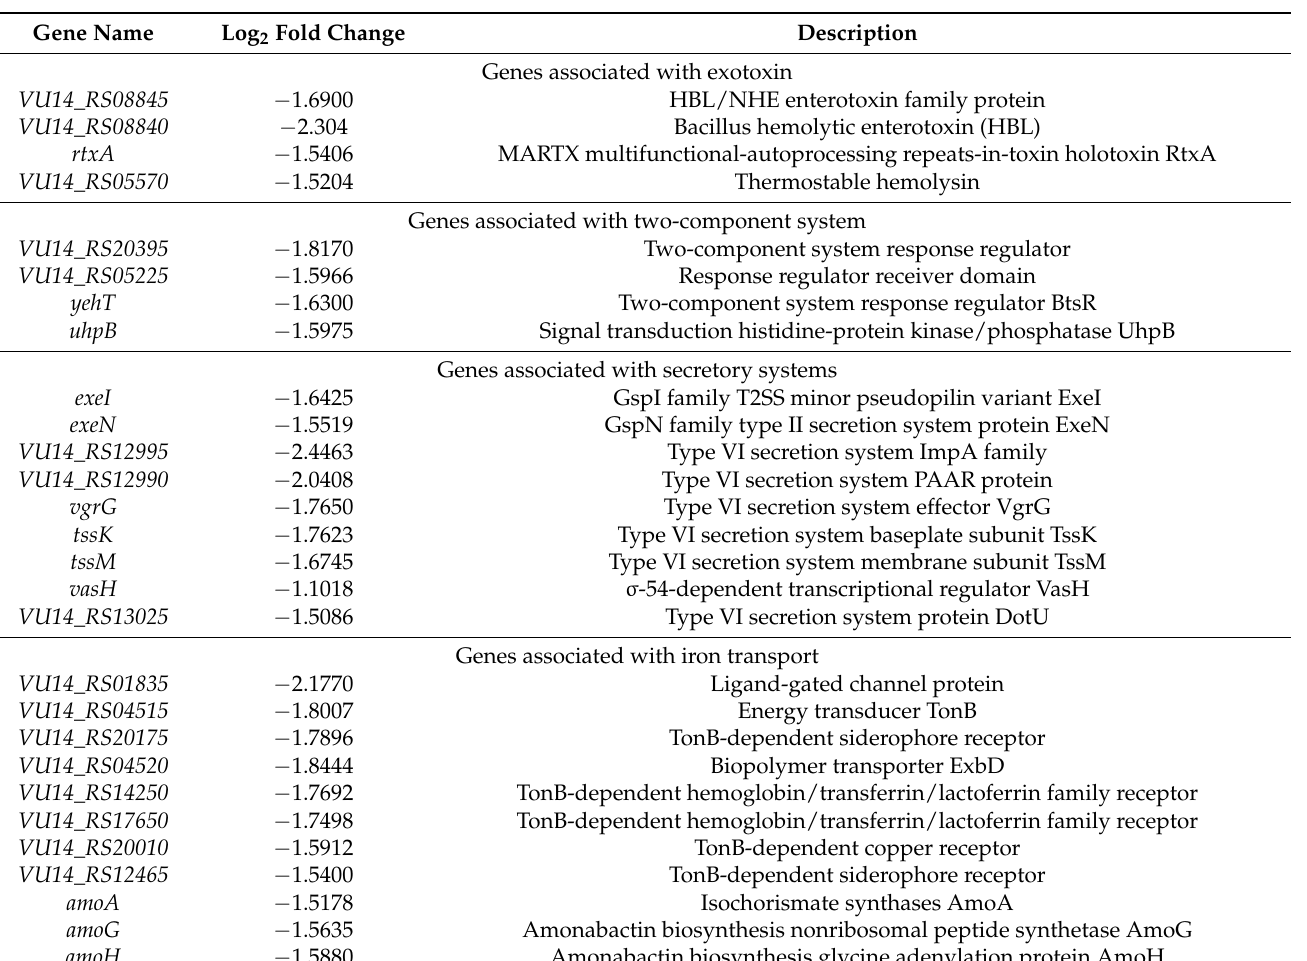
Table 1. The representative downregulated gene list.